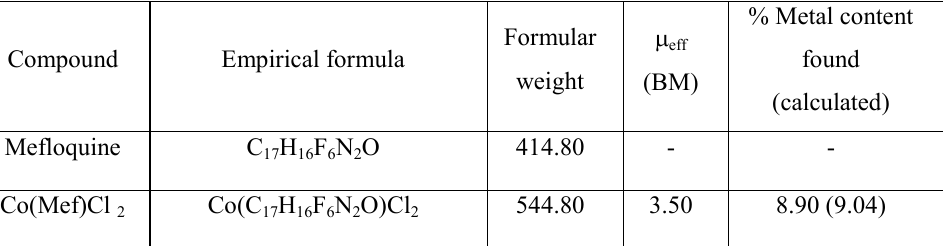
Table 4. Magnetic moment of the ligands and metal